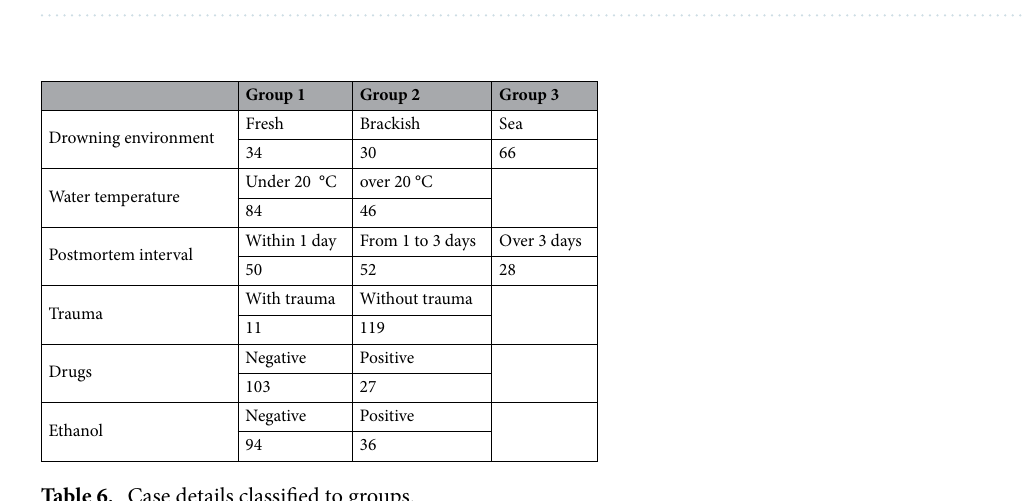
Table 5. Summary of the cases.